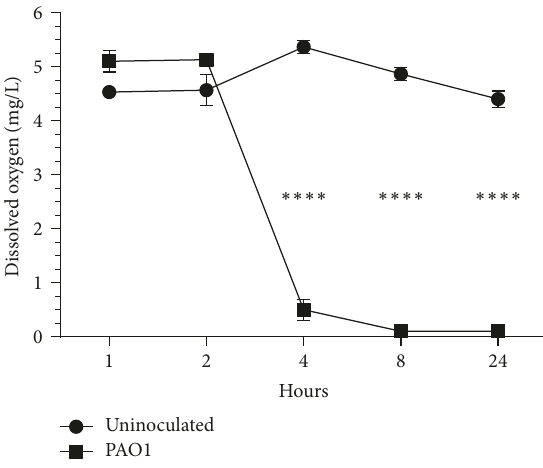
Figure 5: The growth of P. aeruginosa significantly reduces the level of dissolved oxygen in broth. Fifty mL conical tubes containing 15mL of BHI broth were inoculated with ∼ 10 6 CFU of PAO1, 10 2 CFU of VPI 4355, or both organisms and incubated aerobically at 37 ∘ C. The level of DO 2 (mg/L) was measured at 24 h after inoculation. As a control, the level of DO 2 in uninoculated BHI broth was measured at time 0 for a baseline and at 24 h. Values represent the means of three independent experiments ± SEM; ∗∗∗∗ 𝑃 < 0.0001 ; ns, no significant change.